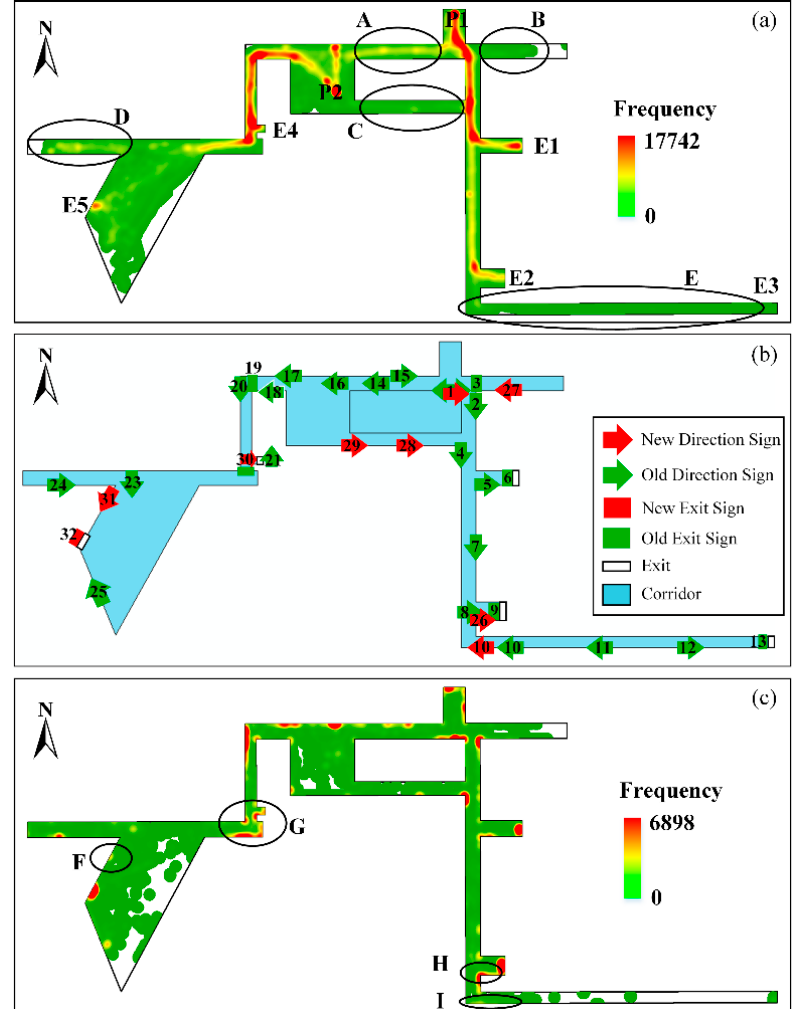
Figure 13. ( a ) Hotspot chart of escape trajectories, ( b ) setup of the optimized sign system, and ( c ) hotspot chart of eye tracking data. ( c ) hotspot chart of eye tracking